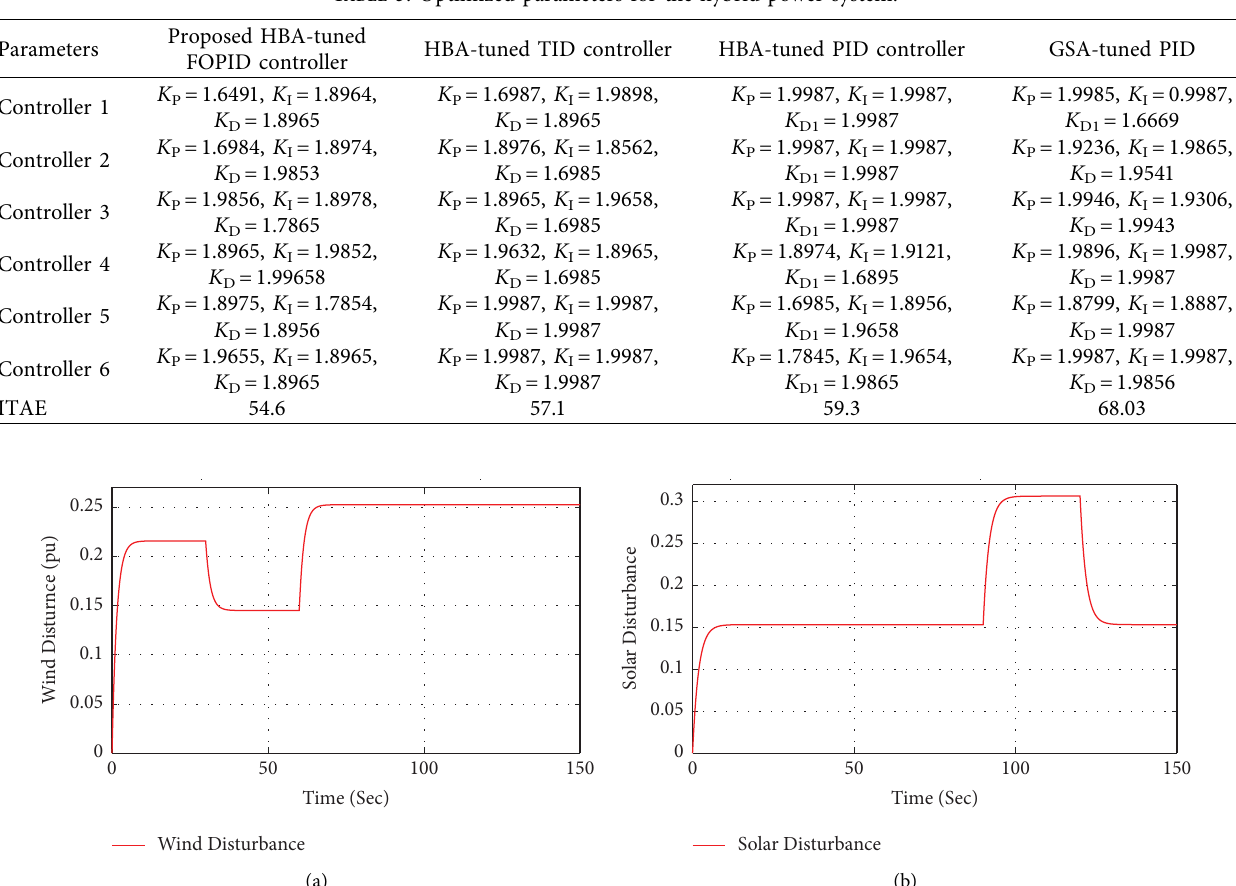
Table 3: Optimized parameters for the hybrid power system.